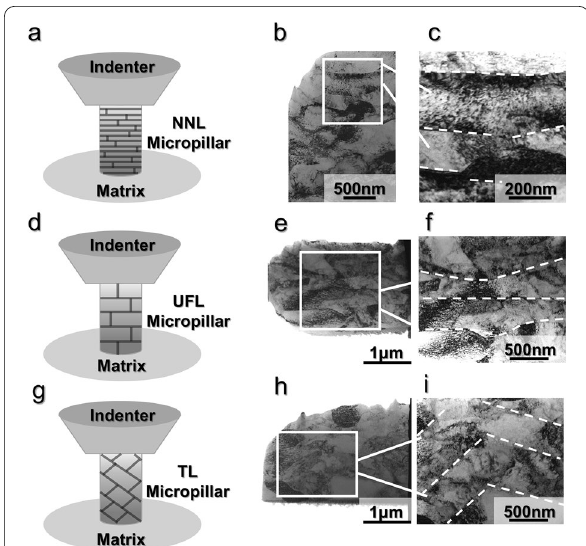
Figure 10 Schematic images and TEM images of the ( a )–( c ) NNL, ( d )–( f ) UFL and ( g )–( l ) TL micropillar after